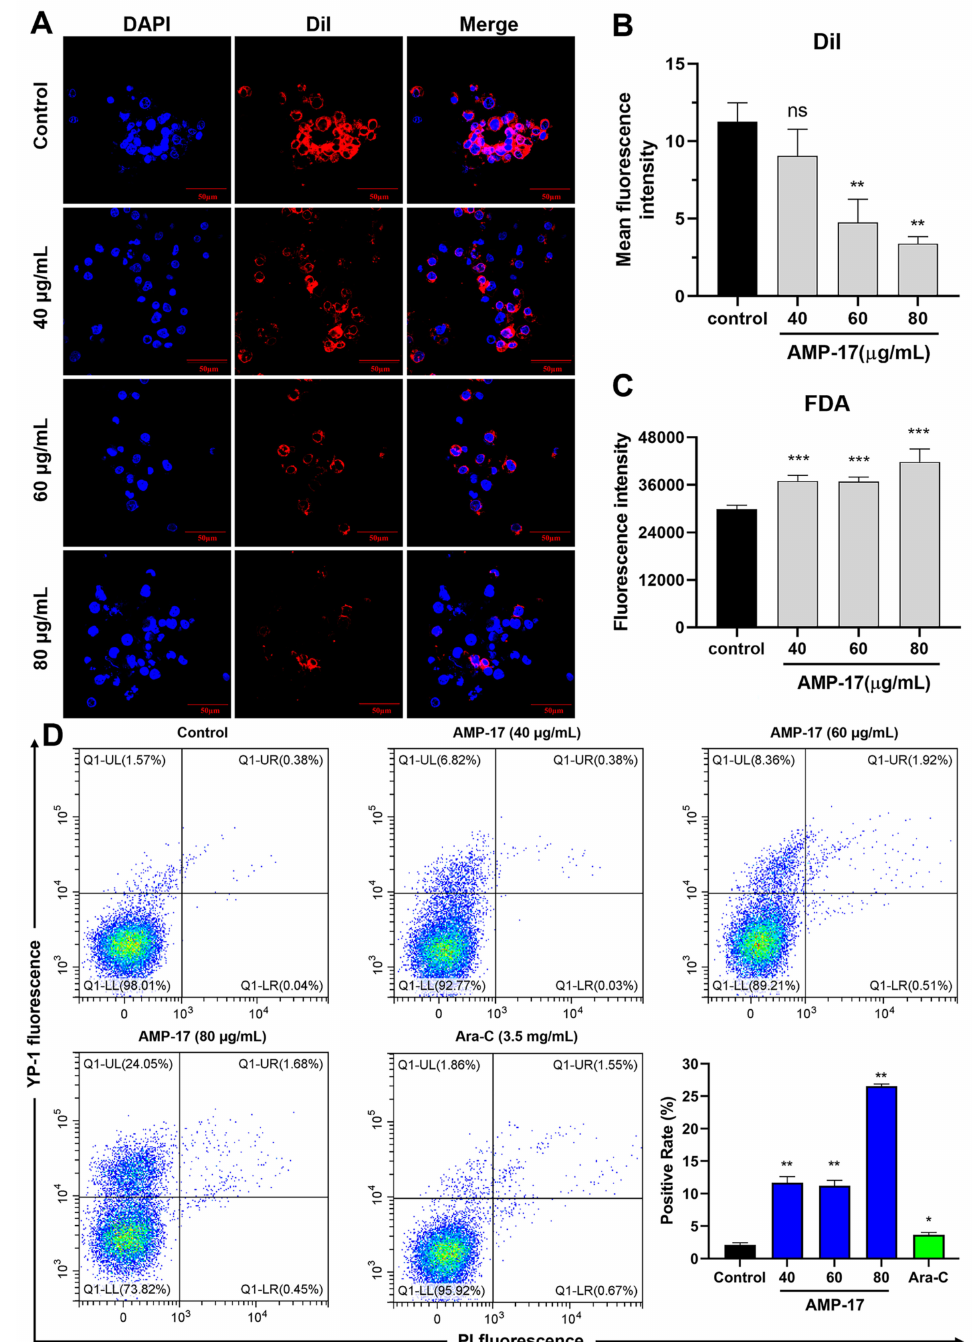
Figure 2. Effect of AMP-17 on the cell membrane of K562 cells. ( A ) Membrane disruption in AMP-17-treated K562 cells was observed using DiI dye and visualized using confocal laser confocal microscopy (CLSM). Images were captured using a 60 × power field. Scale bar, 50 µ m. ( B ) Histogram showing the mean fluorescence intensity of DiI in K562 cells treated with or without AMP-17 (** p < 0.01). ( C ) Fluorescence intensity of intracellular FDA efflux from K562 cells treated with different concentrations of AMP-17 (40, 60 and 80 µ g/mL) for 24 h (*** p < 0.001). The experiment was performed in triplicate and repeated twice. ( D ) Membrane permeability of AMP-17-treated K562 cells was detected by double staining with YP-1/PI and analyzed using flow cytometry. Ara-C was used as a drug control (* p < 0.05, ** p < 0.01). The experiment was independently repeated three